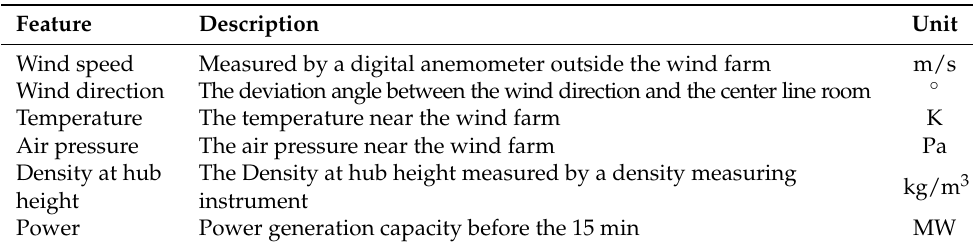
Table 1. Data features used in the experiment.